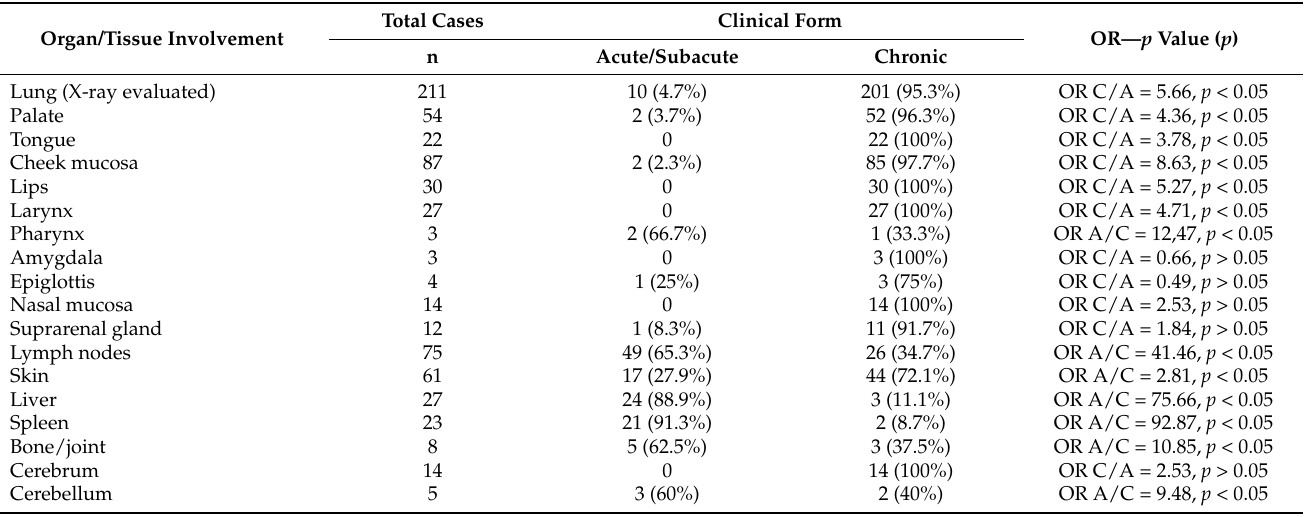
Table 4. Frequency of organ or tissue involved according to clinical form registered in the stud- ied cohort.